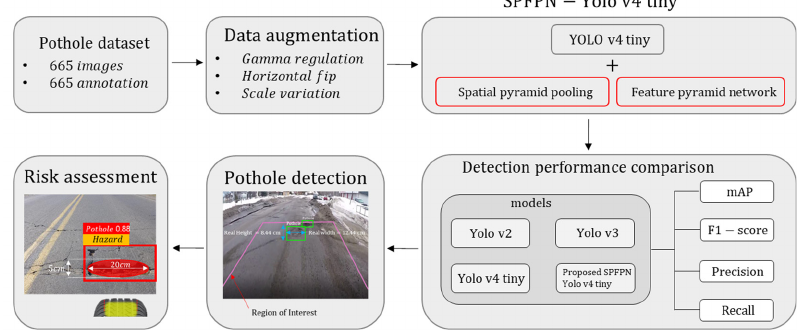
Figure 1. Research and risk assessment procedure using SPFPN YOLOv4 tiny